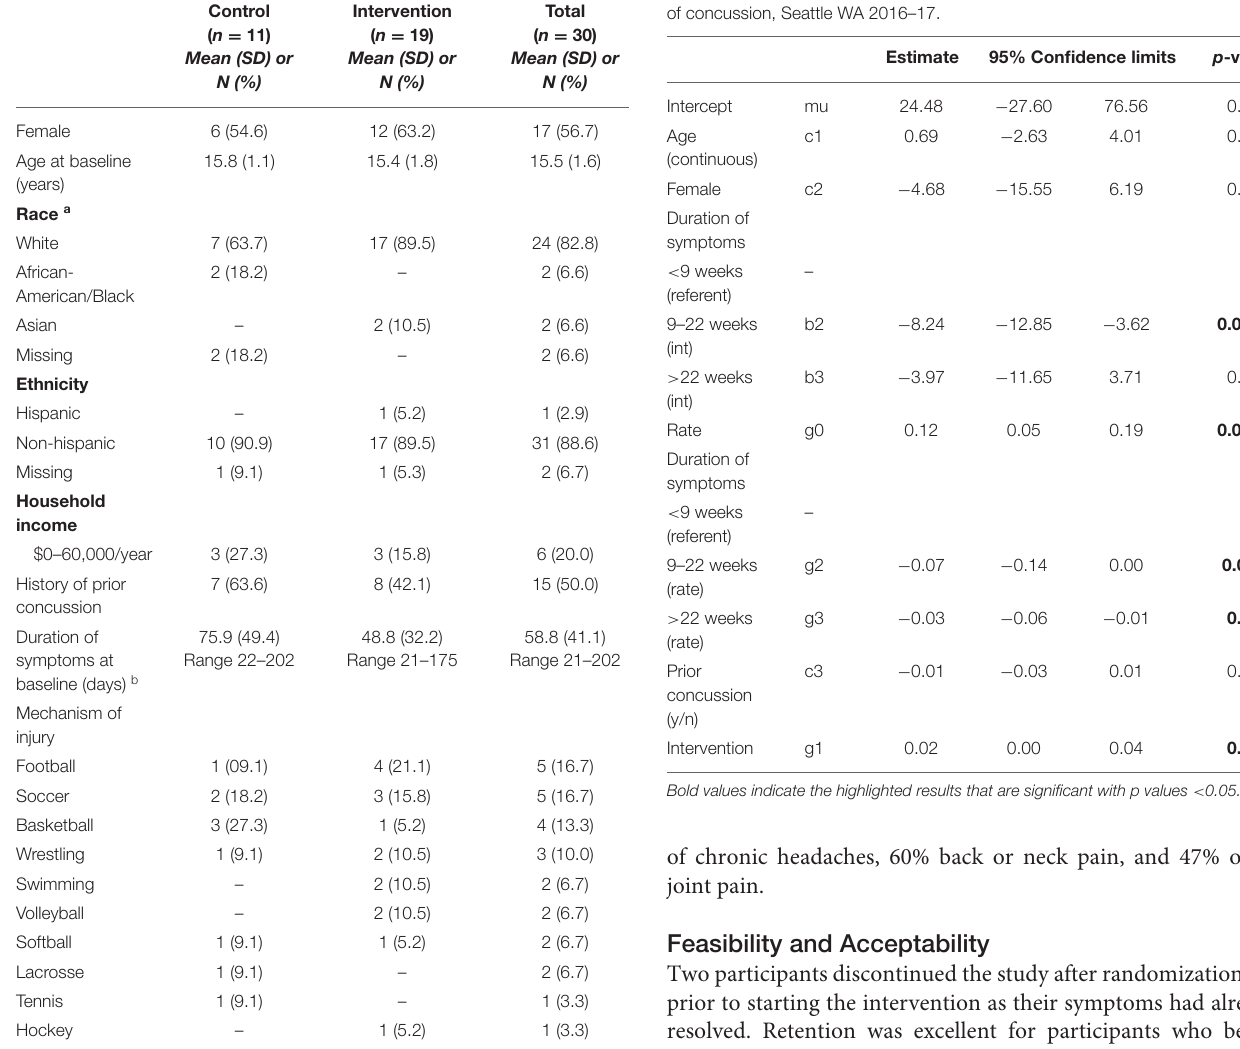
TABLE 1 | Demographic characteristics of concussed youth participating in Sub-Threshold Exercise Program (STEP) study, Seattle WA 2016–17.